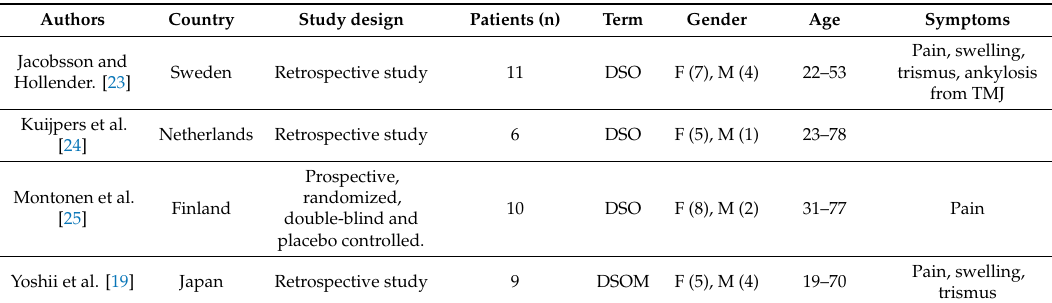
Table 2. Data summary of the included